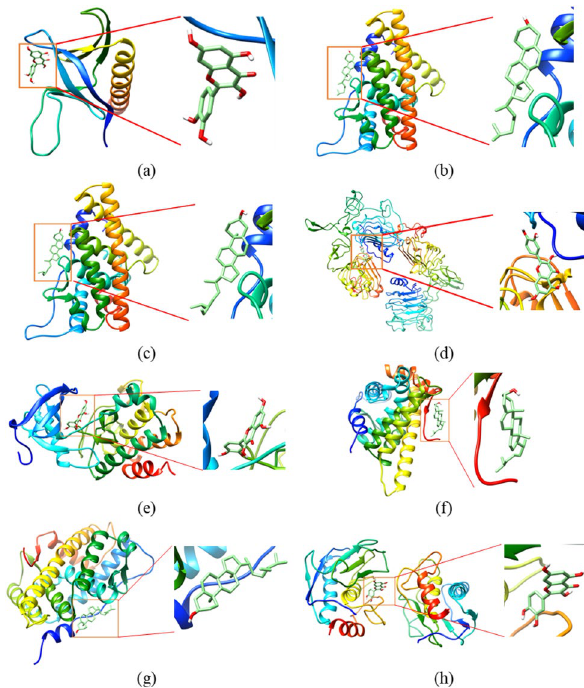
Fig. 6 Conformations of the 8 strong bindings identified from molecular docking between the 6 active ingredients of S. nigrum and the 6 hub protein targets, a AKT1 and quercetin, b ESR1 and cholesterol, c ESR1 and 3-epi-beta-sitosterol, d EGFR and quercetin, e SRC and quercetin, f AR and cholesterol, g AR and 3-epi-beta- sitosterol, and h MMP9 and